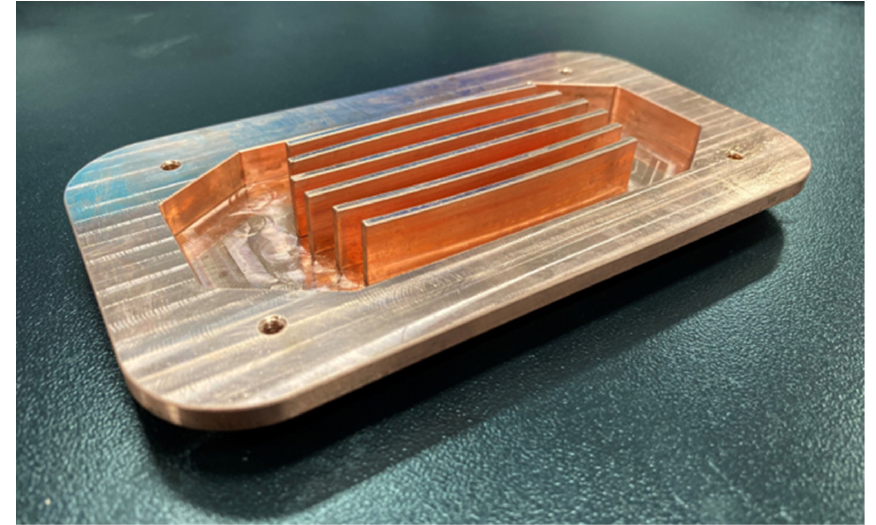
Figure 2. Inside view of the upper part of the target substrate, showing the six cooling fins. (3)